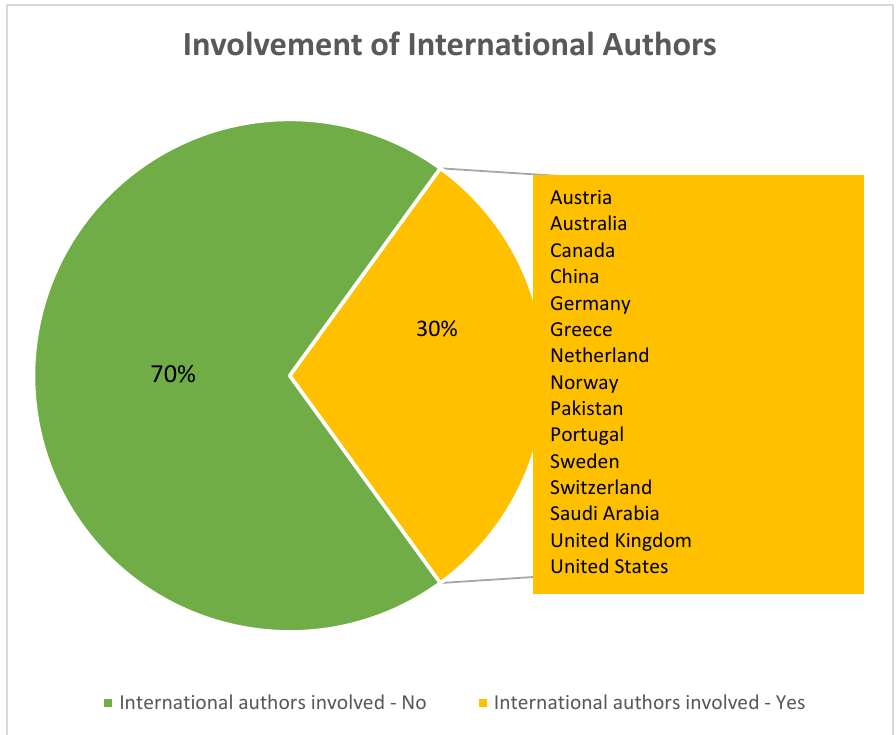
Figure 8. Involvement of International Authors.